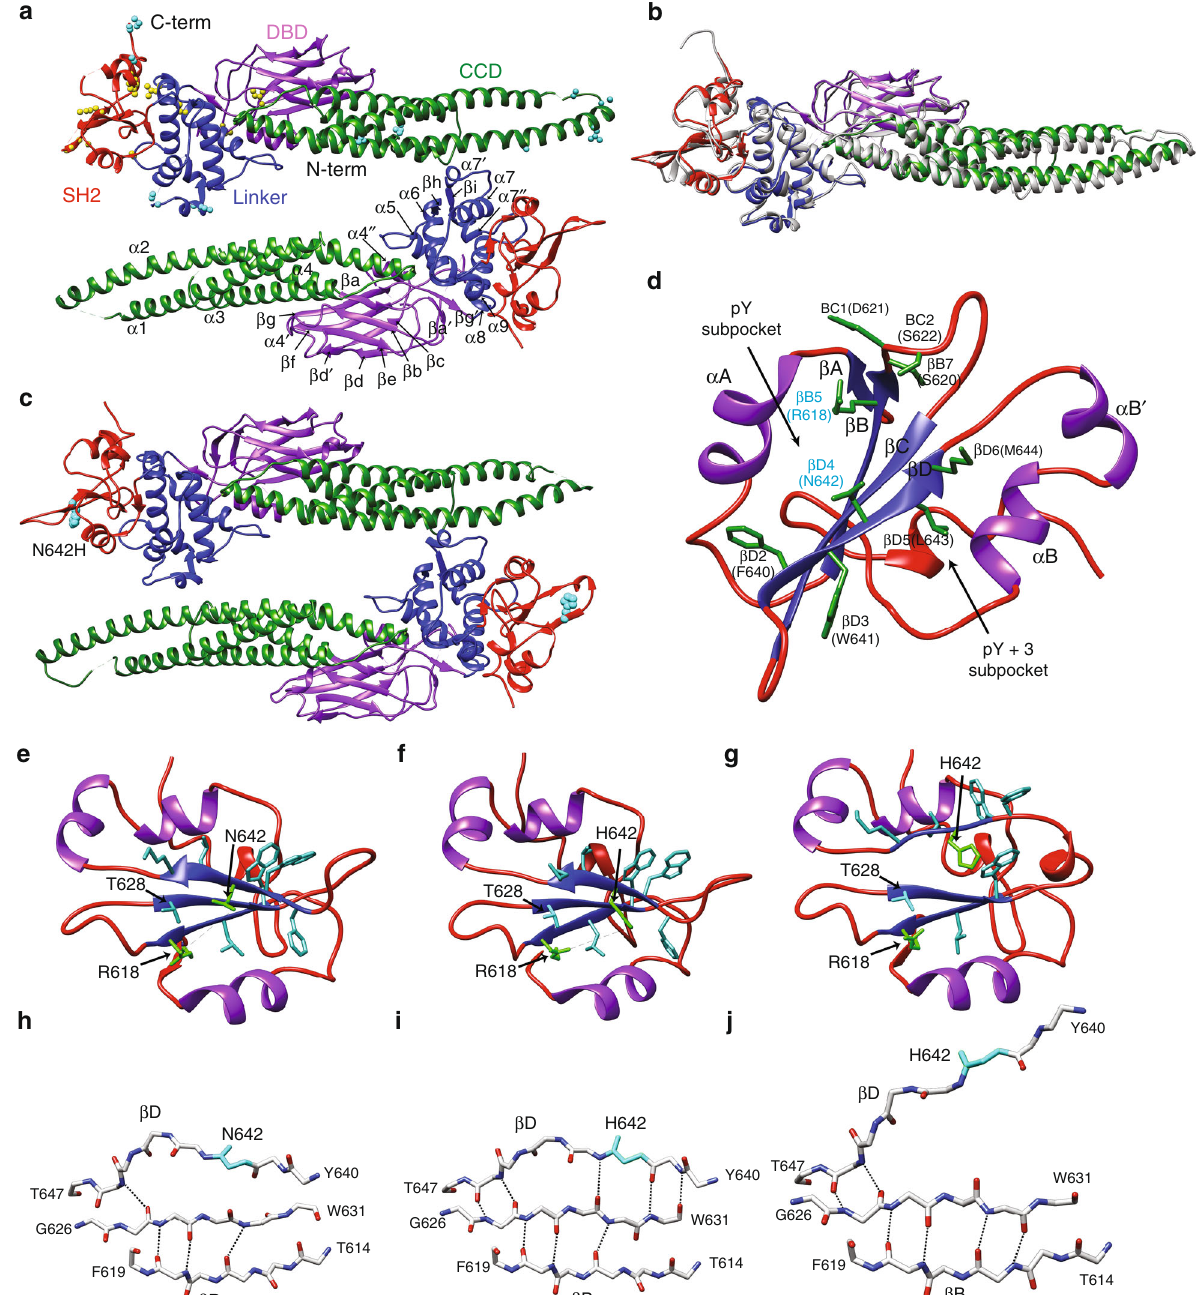
Fig. 5 Structural architecture of human STAT5B and STAT5B N642H . a Crystal structure of the STAT5B unphosphorylated dimer illustrating the CCD (green), DBD (purple), linker domain (blue), and SH2 domain (red). The top monomer shows residue changes between human STAT5A and human STAT5B in yellow spheres, whereas differences between human STAT5A and murine STAT5A are shown in cyan spheres. Secondary structural elements are appropriately labeled on the bottom monomer. Nomenclature for structural elements in the CCD, DBD, and linker domain is established on precedents for STAT5A. b Overlay of human STAT5B with murine STAT5A (gray). c Crystal structure of the STAT5B N642H unphosphorylated dimer with a similar color scheme as in a . The mutated N642H position is indicated by cyan spheres. d The SH2 domain of wild-type STAT5B with secondary structural elements labeled based on nomenclature for STAT-type SH2 domains. Different conformations of the STAT5B SH2 domain are shown for the wild-type ( e ) and mutant ( f , g ). The hydrogen bonding network for the β -sheet backbone in the SH2 domain for STAT5B ( h ) and STAT5B N642H ( i , j ) are shown in two distinct conformations. Source data are provided as in the PDB: 6MBW (STAT5B) and 6MBZ (STAT5B N642H